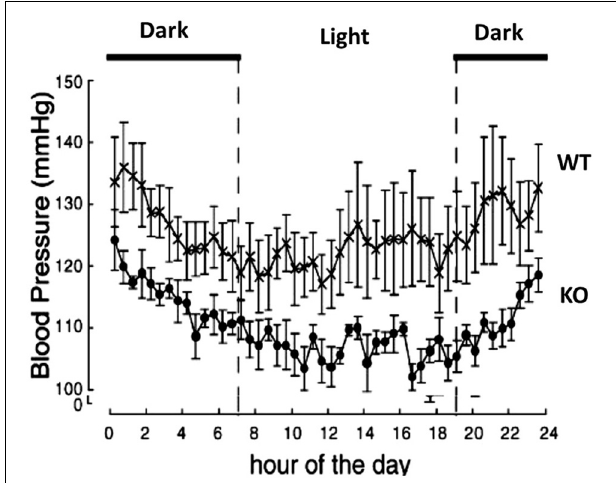
FIGURE 3 | Prepro-orexin knockout mice have lower blood pressures throughout the circadian cycle. The knockout mice have lower blood pressure in both the light and dark periods of the diurnal cycle relative to the wild type control mice. Filled circles: KO mice; crosses: WT mice. (Figure used with permission from Kayaba et al.,